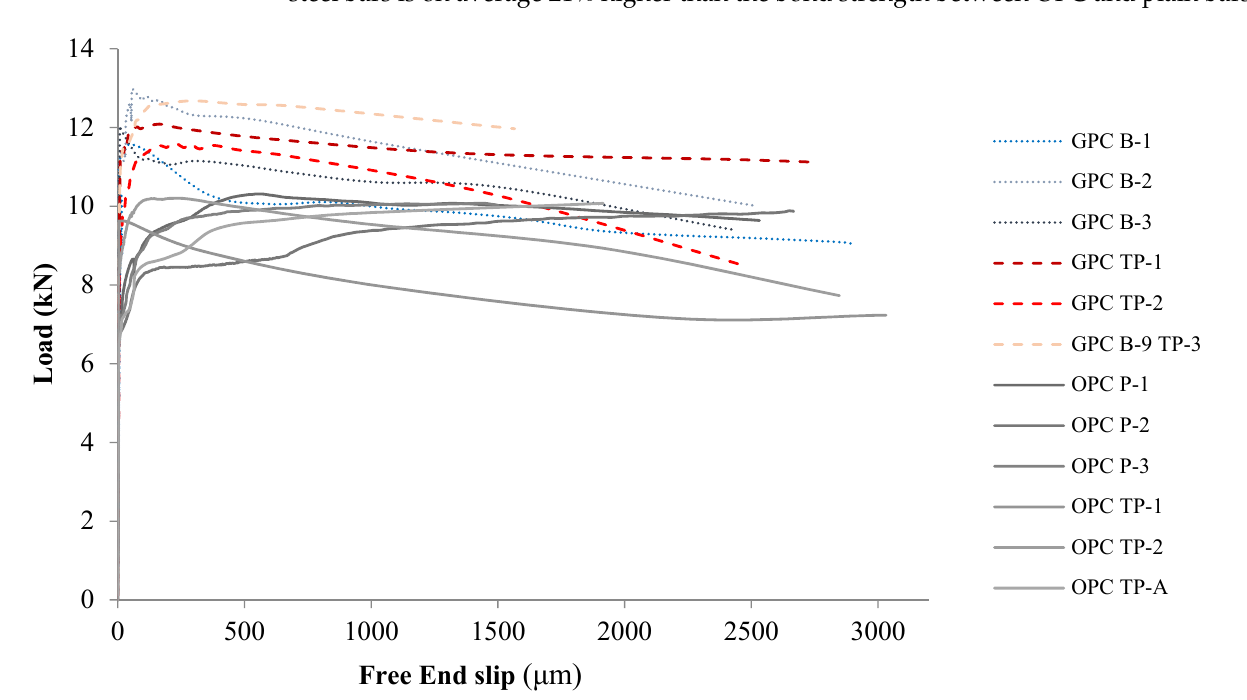
Figure 15. Load–slip graphs of plain bar reinforced OPC and GPC.